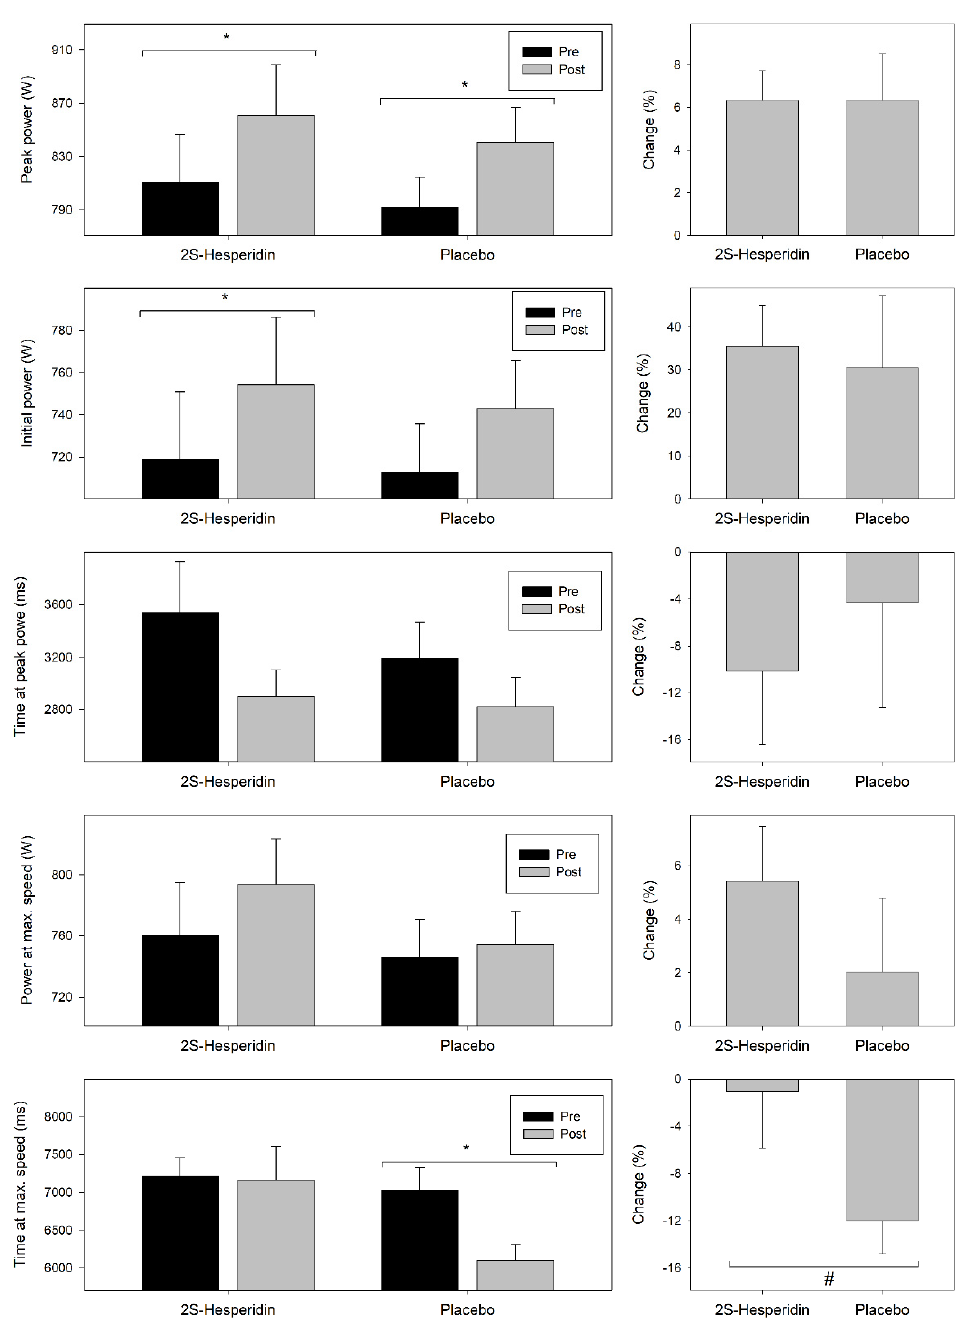
Figure 4. Changes in parameters evaluated during the Wingate test prior and after supplementation. Values are mean ± SE. * Within-group significant changes ( p ≤ 0.05). # Between group trend t significant changes ( p = 0.05–0.010).